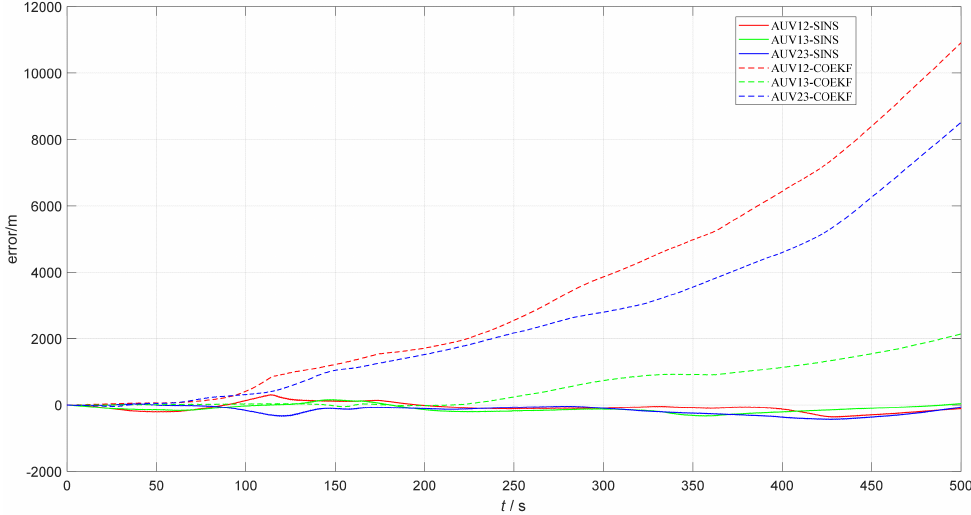
Figure 11. Relative horizontal distance error for multi-boat cooperative